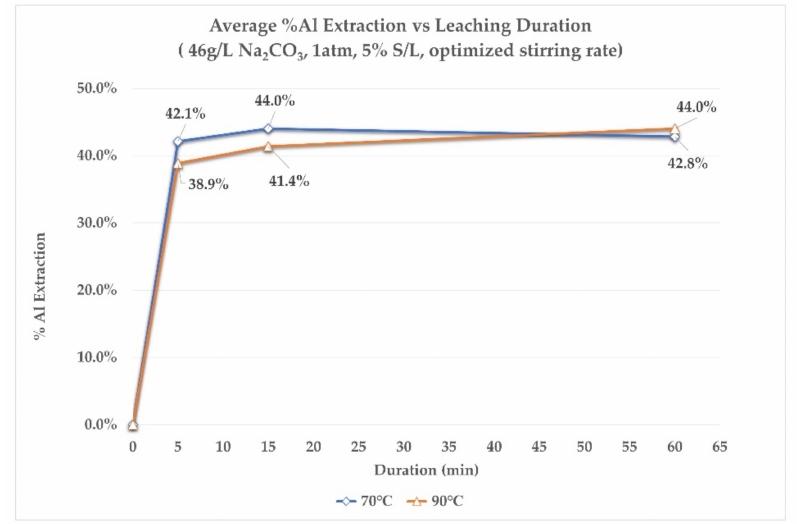
Figure 6. The %Al extraction rate at different leaching times, at 70 ◦ C and 90 ◦